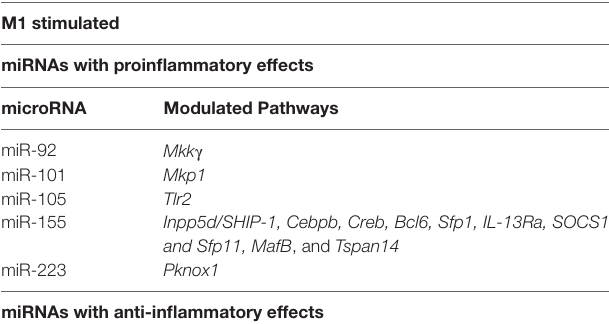
TABLe 2 | Summary of miRNAs linked with M1 or M2 phenotype. M1